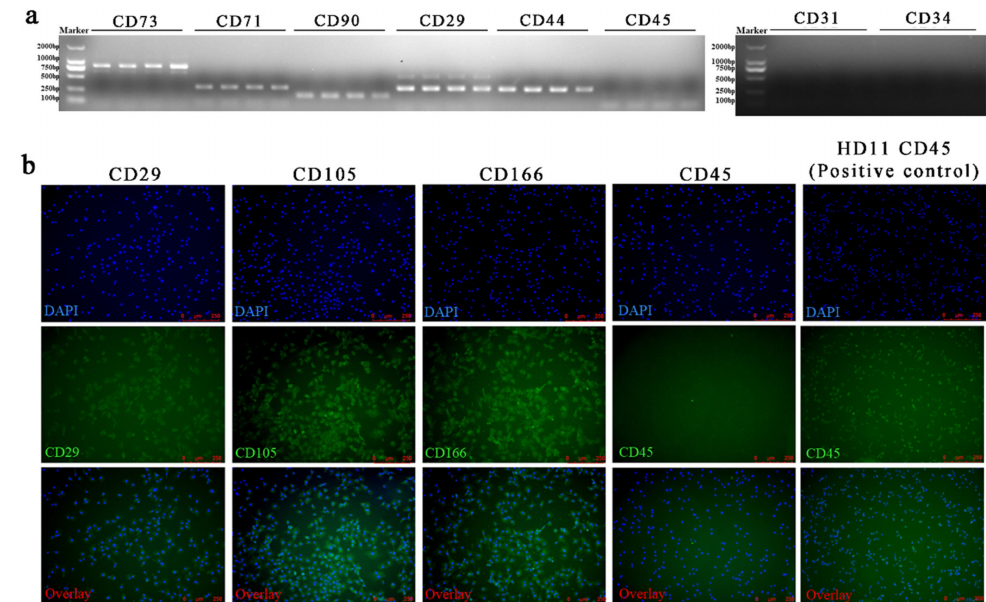
Figure 3. Identification of chicken BM-MSCs. Cell surface markers of BM-MSCs were detected by RT-PCR and IF. ( a ) The RT-PCR results showed that BM-MSCs were positive for CD73 , CD71 , CD90 , CD29 , and CD44 but negative for CD45 , CD31 , and CD34 . Every cell surface marker was detected four times to ensure repeatability. ( b ) The IF results showed that BM-MSCs expressed CD29, CD105, and CD166 but not expressed CD45. HD11 was employed as the positive control of